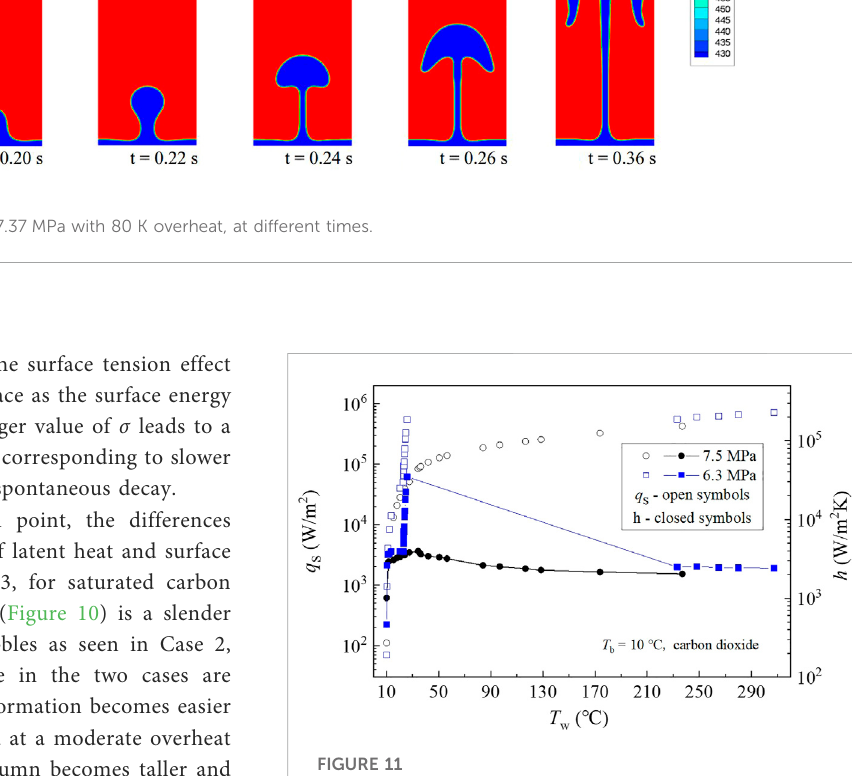
FIGURE 11 Surfaceheat fl uxandheattransfercoef fi cient atdifferentwall